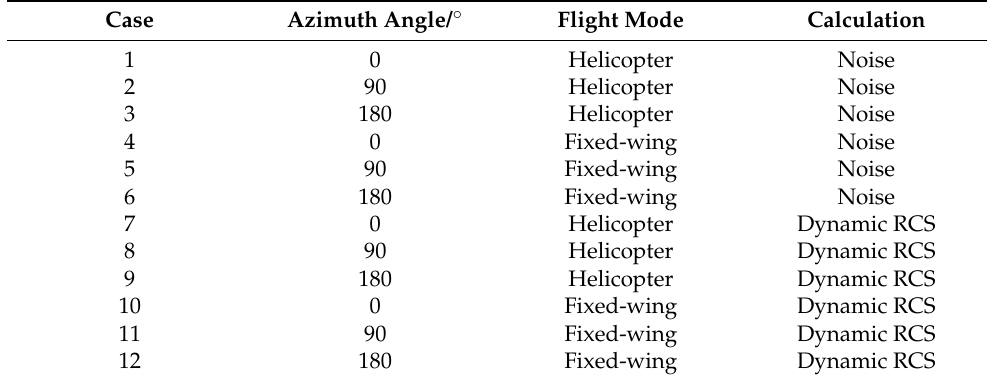
Table 3. Various parameters of the 12 simulation cases considered in this paper. Case Azimuth Angle/ ◦ Flight Mode